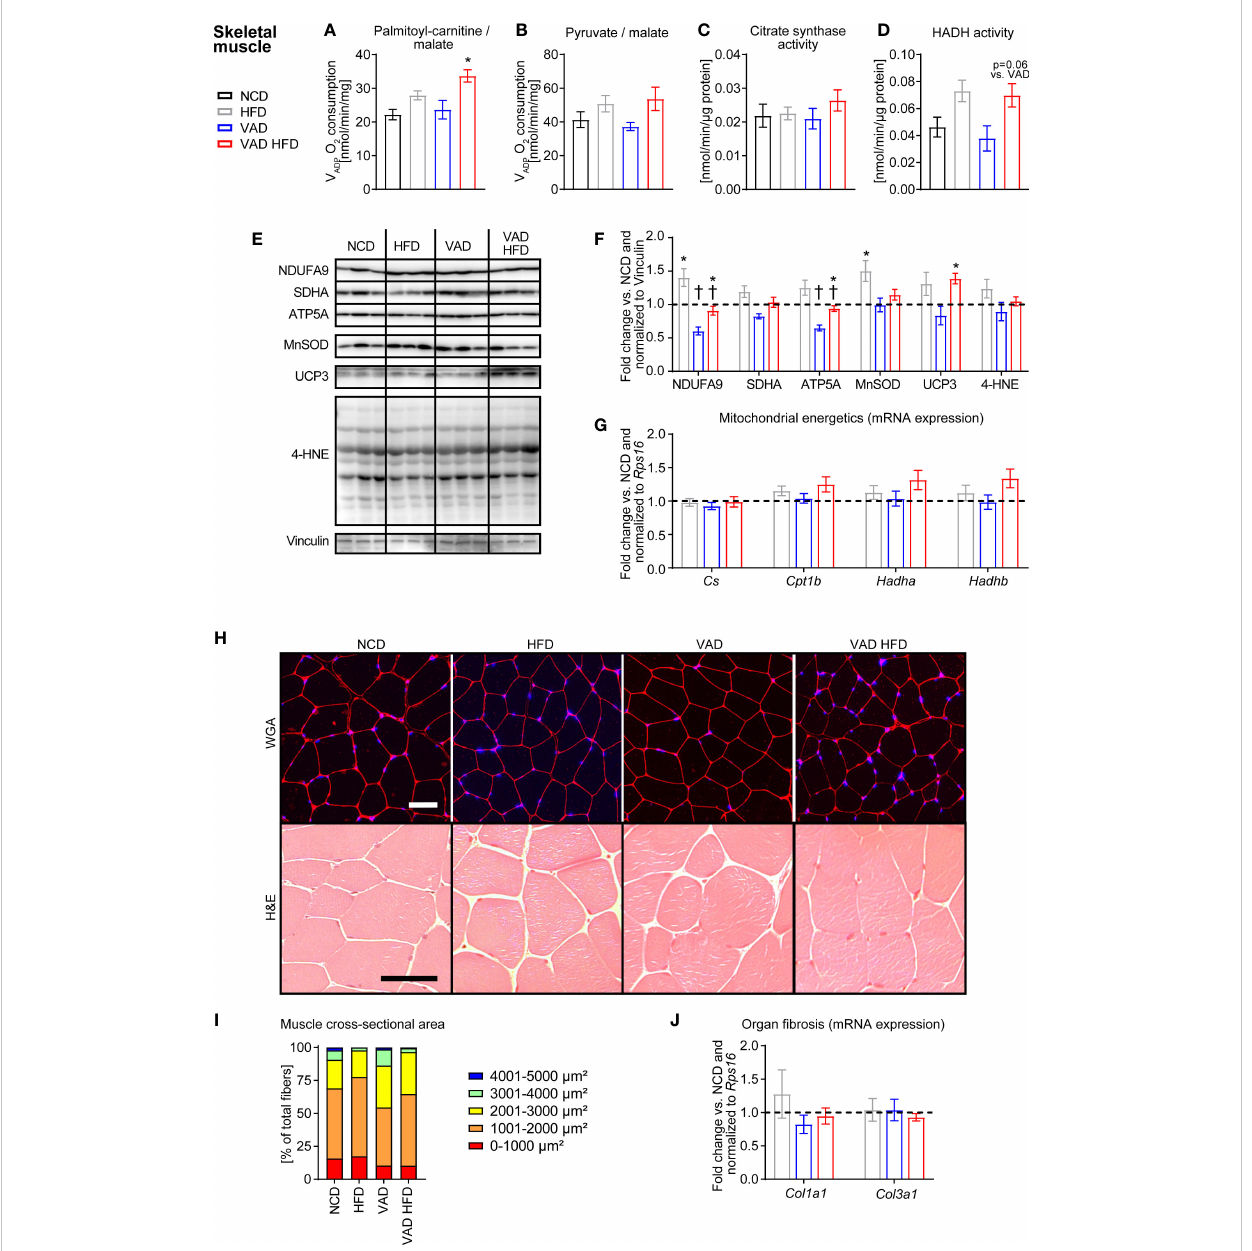
FIGURE 3 VitA does not impair skeletal muscle mitochondrial function and morphological structure in DIO. Data are reported as mean values ± SE. Two-way ANOVA was performed to analyze differences by HFD feeding and VitA. Results of post-hoc analyses for each comparison are summarized by symbols as de fi ned: # p<0.05 for HFD feeding and $ p<0.05 for VitA. No signi fi cant effect for the interaction between HFD feeding and VitA was determined. V ADP of isolated skeletal muscle mitochondria with (A) palmitoyl-carnitine (#) and (B) pyruvate (#) each combined with malate as substrates (n=6-8). (C) Citrate synthase and (D) HADH (#) activity in skeletal muscle (n=7-8). (E) Representative immunoblots and (F) densitometric analysis of NDUFA9 (#, $), SDHA (#, $), ATP5A (#, $), MnSOD (#),UCP3 (#), and 4-HNE normalized to Vinculin. Data are presented as fold change relative to NCD (assigned as 1.0; dashed line), n=6. (G) mRNA expression of transcripts involved in mitochondrial energetics presented as fold change relative to NCD and normalized to Rps16 (assigned as 1.0; dashed line), n=8. (H) Representative WGA and H&E stains of skeletal muscle sections (scale bars: 50 m m each). (I) Mean cross-sectional area of skeletal muscle fi bers presented as percentage of total fi bers (# for 4001-5000 μm², n=5-6). (J) mRNA expression of transcripts involved in organ fi brosis presented as fold change relative to NCD and normalized to Rps16 (assigned as 1.0; dashed line), n=8. *p < 0.05 vs. normocaloric diet same VitA availability, † p<0.05 vs. VitA suf fi ciency same caloric